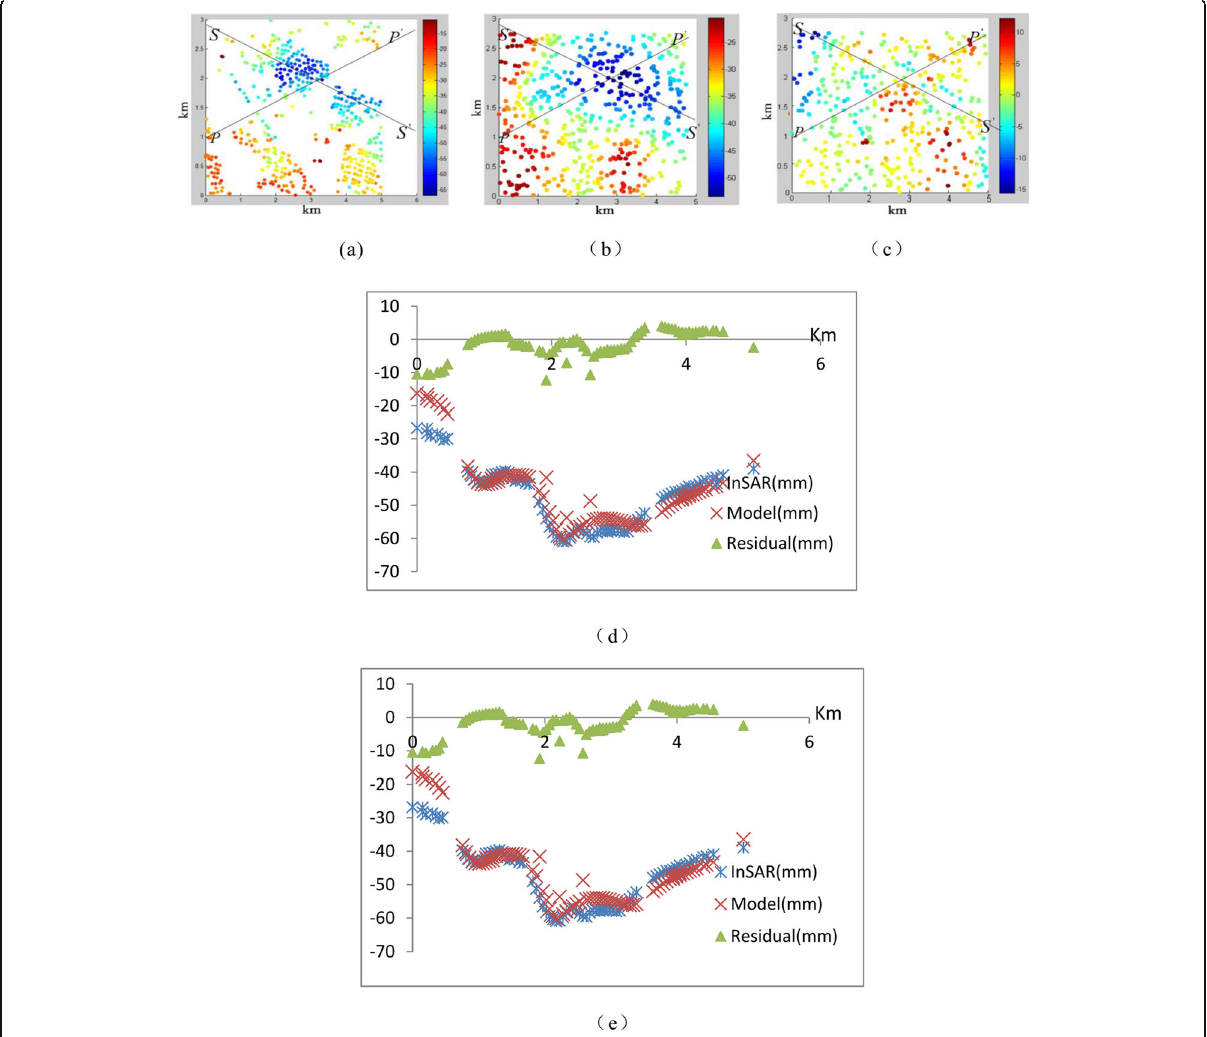
Fig. 17 Comparison of typical funnel observations and analog value. a InSAR result(mm). b Model simulation(mm). c Observed and simulated residuals. d P-P' direction observations, analog values, and residuals. e S-S' direction observations, analog values and